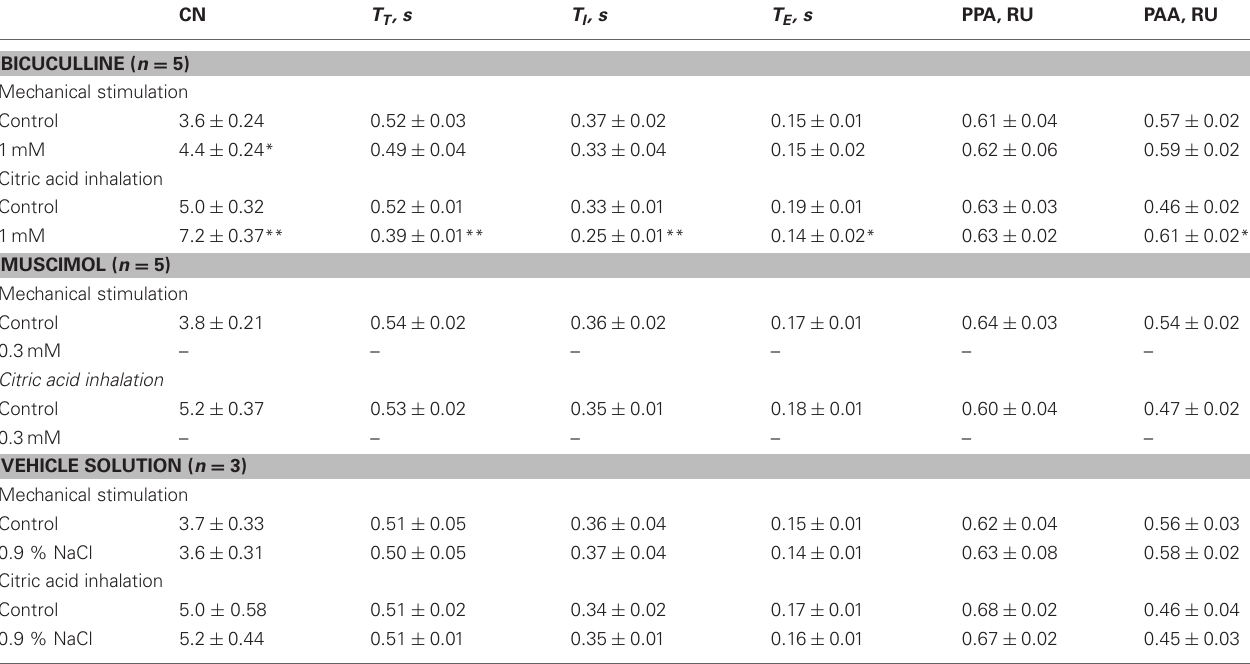
Table 2 | Changes in cough-related variables recorded ∼ 10min following bilateral microinjections of 1mM Bicuculline, 0.3 Muscimol, and vehicle solution into the